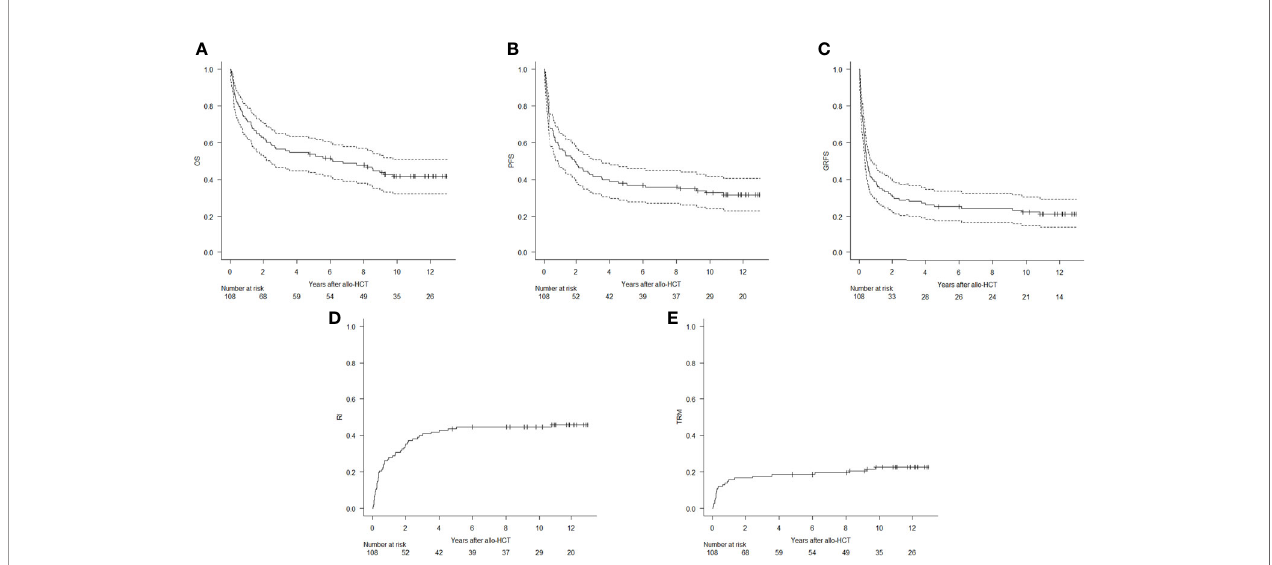
FIGURE 1 | Kaplan – Meier estimates of overall survival (OS, A ), progression-free survival (PFS, B ), and graft- versus -host-free/relapse-free survival (GRFS, C ), and cumulative incidence of relapse/progression (RI, D ) and transplant-related mortality (TRM, E ).